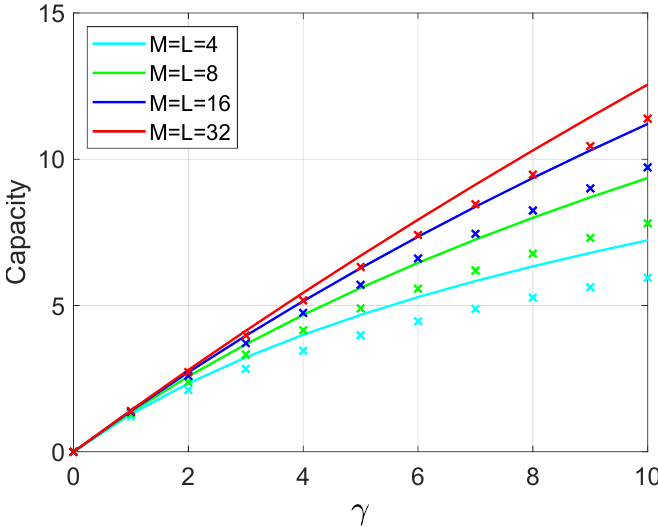
Figure 4. Analytical upper bound sum-rate capacity compared with